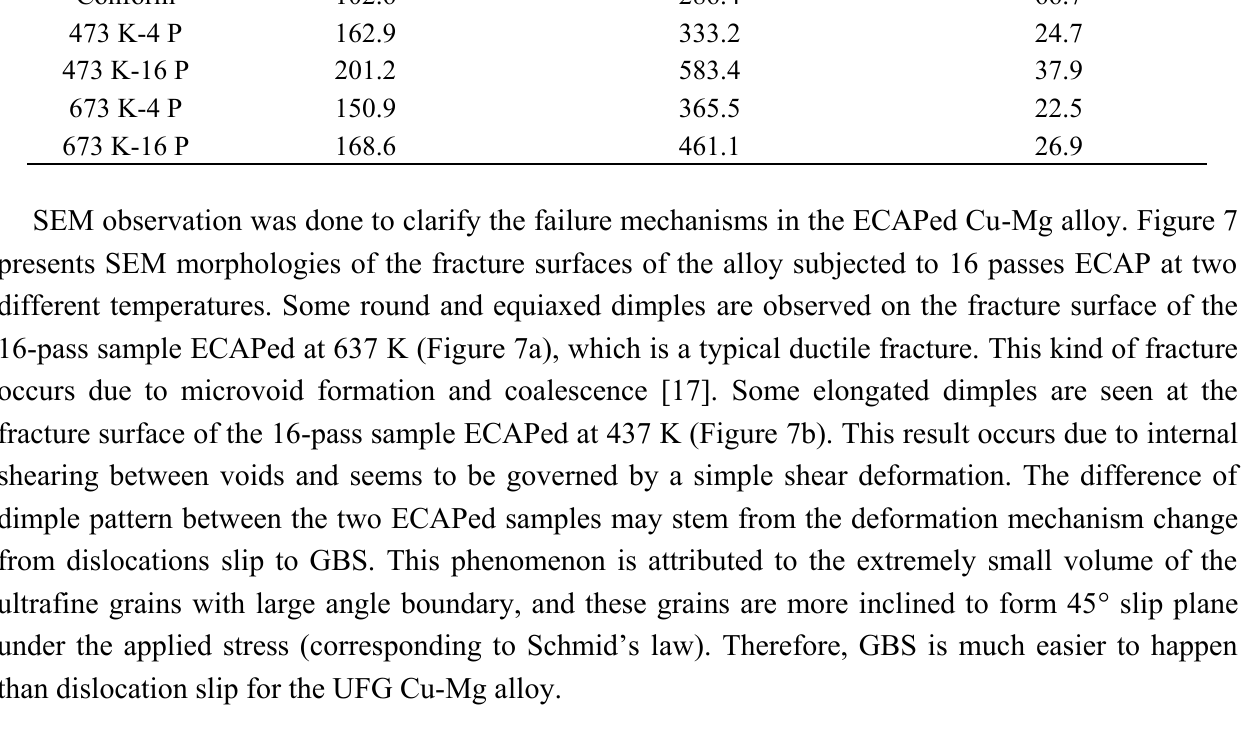
Figure 7. SEM fracture surface of the samples subjected to 16 passes ECAP at ( a ) 637 K and ( b ) 473